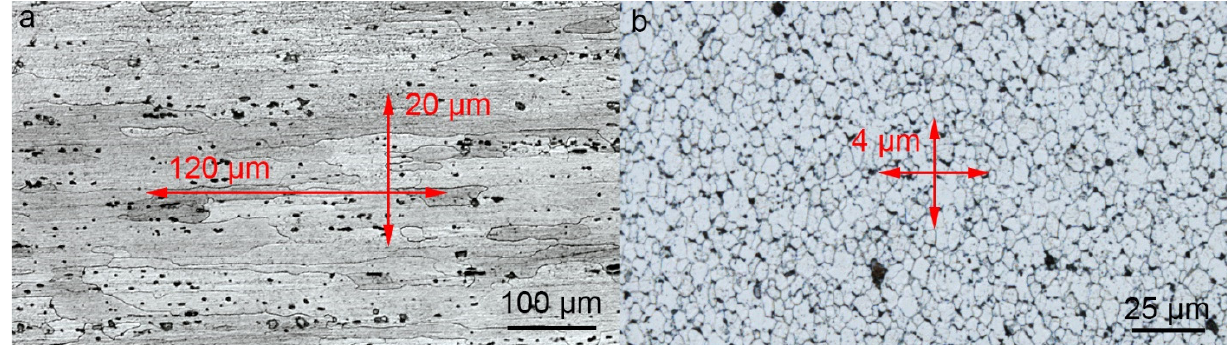
Figure 3. Grain structure of base metal ( a ) and stir zone ( b ).